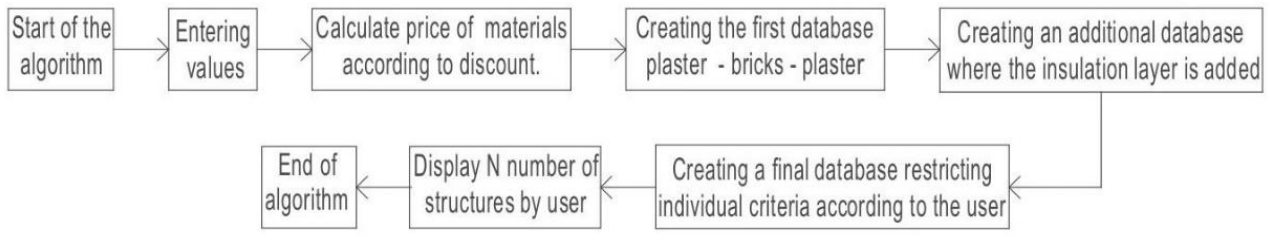
Figure 2. Flowchart showing a brief algorithm progress.